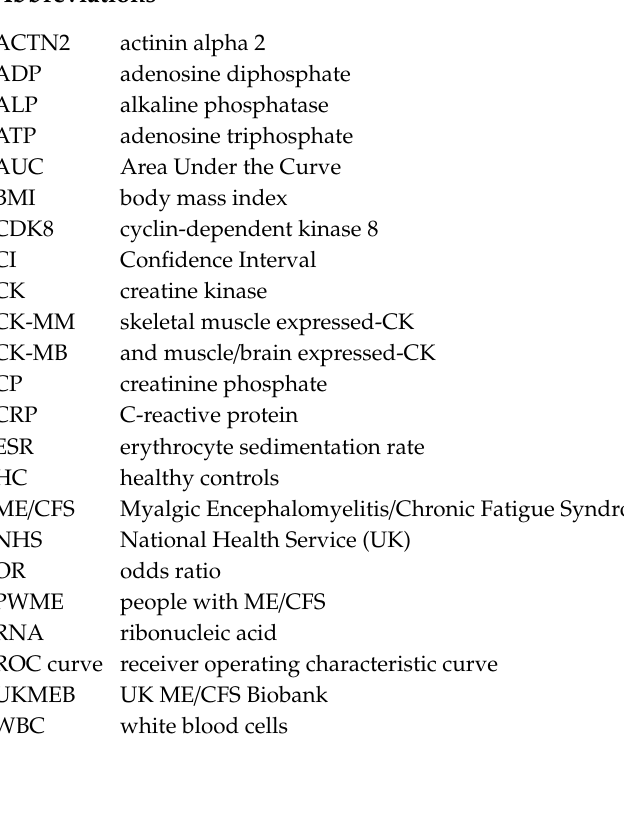
Figure S1: (Absolute) Spearman’s correlations between laboratory tests across all samples; Figure S2: Laboratory tests across all